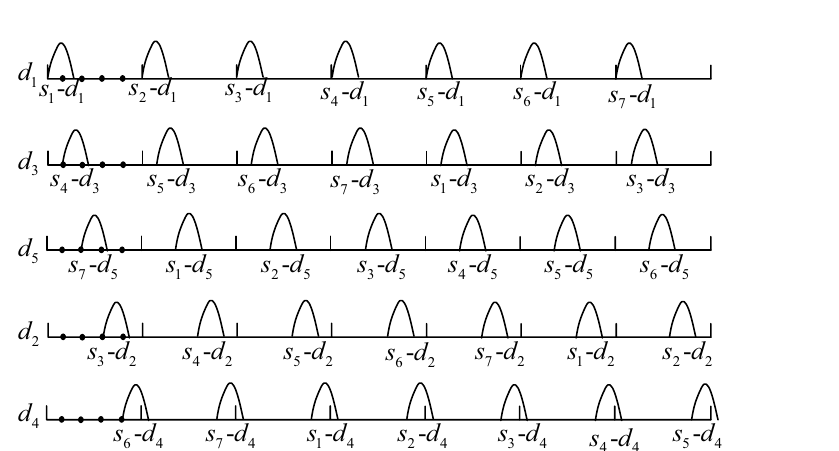
Figure 13. The position relationship of moving and stationary blades during the 1/ N s rotation cycle. ( a ) d 1 forced:0/35 cycle. ( b ) d 3 forced: 1/35 cycle. ( c ) d 5 forced: 2/35 cycle. ( d ) d 2 forced: 3/35 cycle. ( e ) d 4 forced: 4/35 cycle.